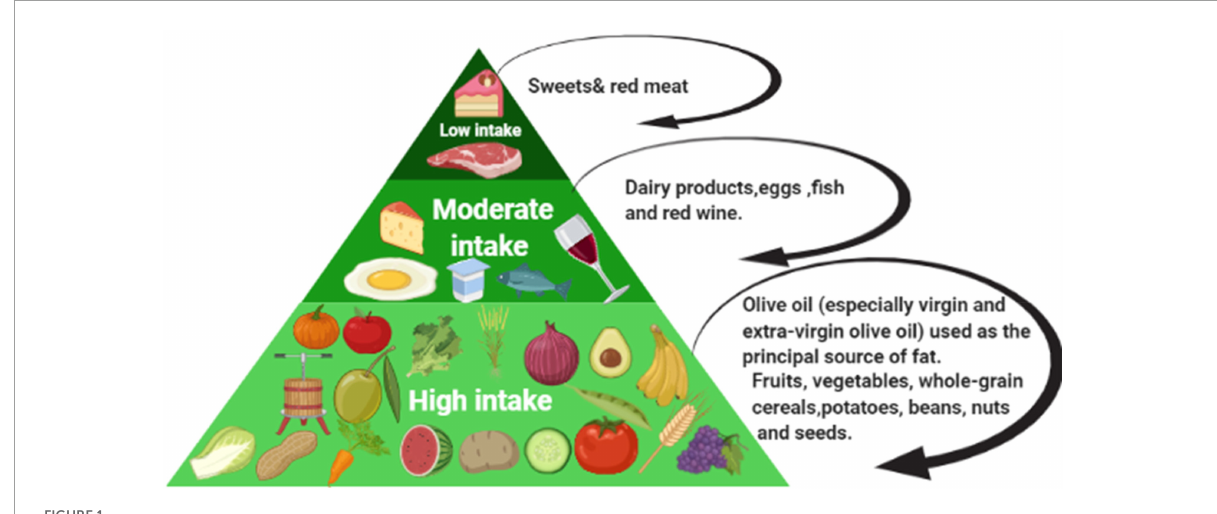
FIGURE1 The Mediterranean diet intake